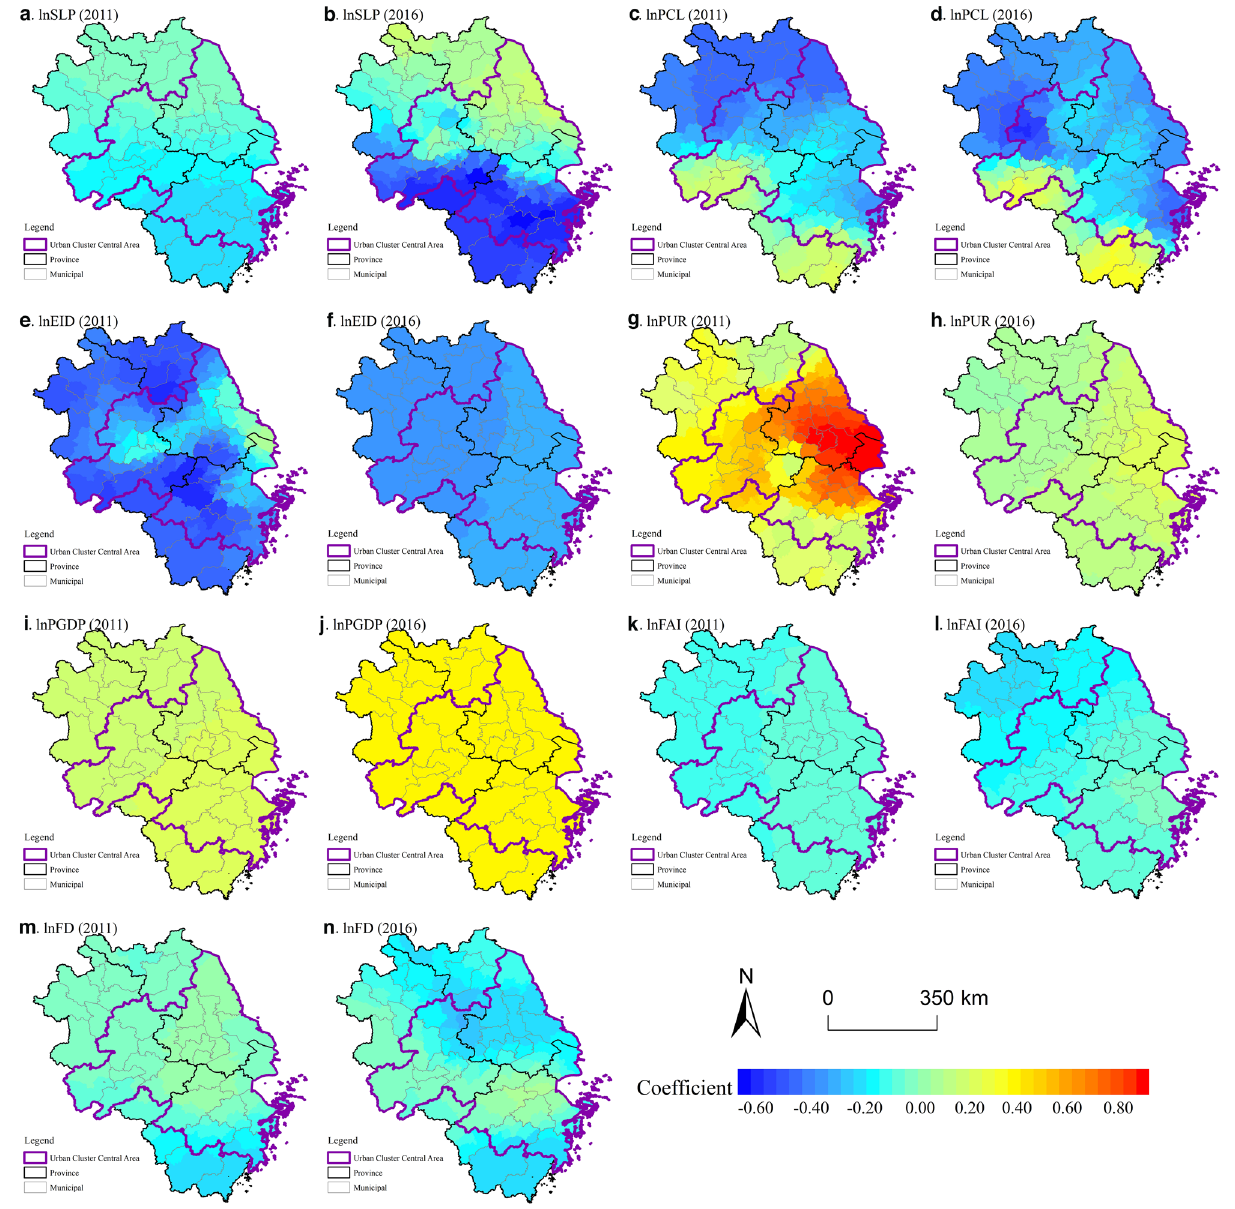
Figure 6. Spatial patterns of coefficients in the MGWR. ( a ) lnSLP(2011); ( b ) lnSLP(2016); ( c ) lnPCL(2011); ( d ) lnPCL(2016); ( e ) lnEID(2011); ( f ) lnEID(2016); ( g ) lnPUR(2011); ( h ) lnPUR(2016); ( i ) lnPGDP(2011); ( j ) lnPGDP(2016); ( k ) lnFAI(2011); ( l ) lnFAI(2016); ( m ) lnFD(2011); ( n ) lnFD(2016). Software: Arcgis 10.7. URL: https:// www. esri. com/ zh- cn/